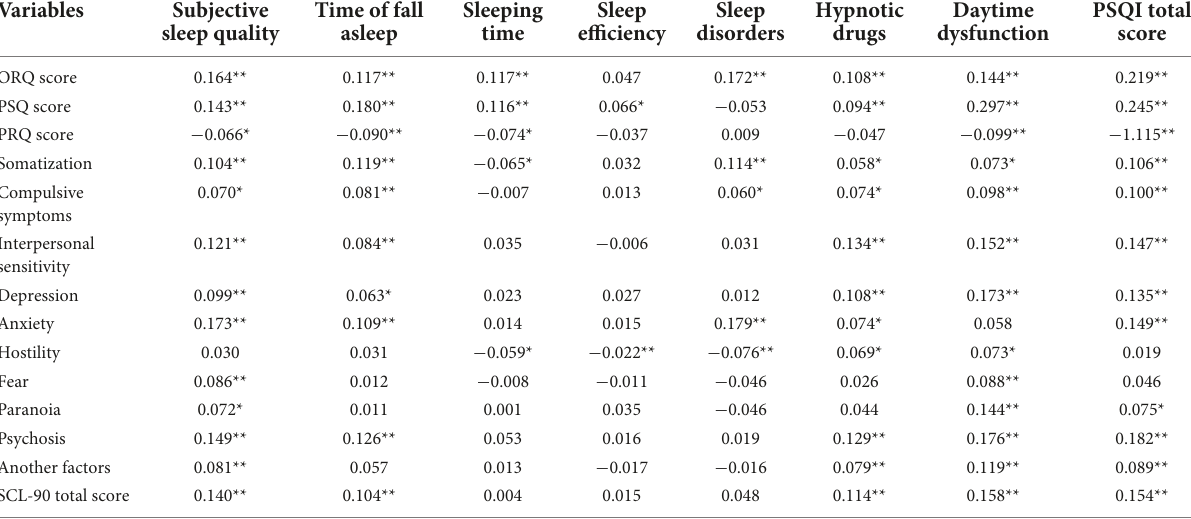
TABLE 3 Correlation analysis of occupational stress, mental health and sleep quality in petroleum workers. Variables